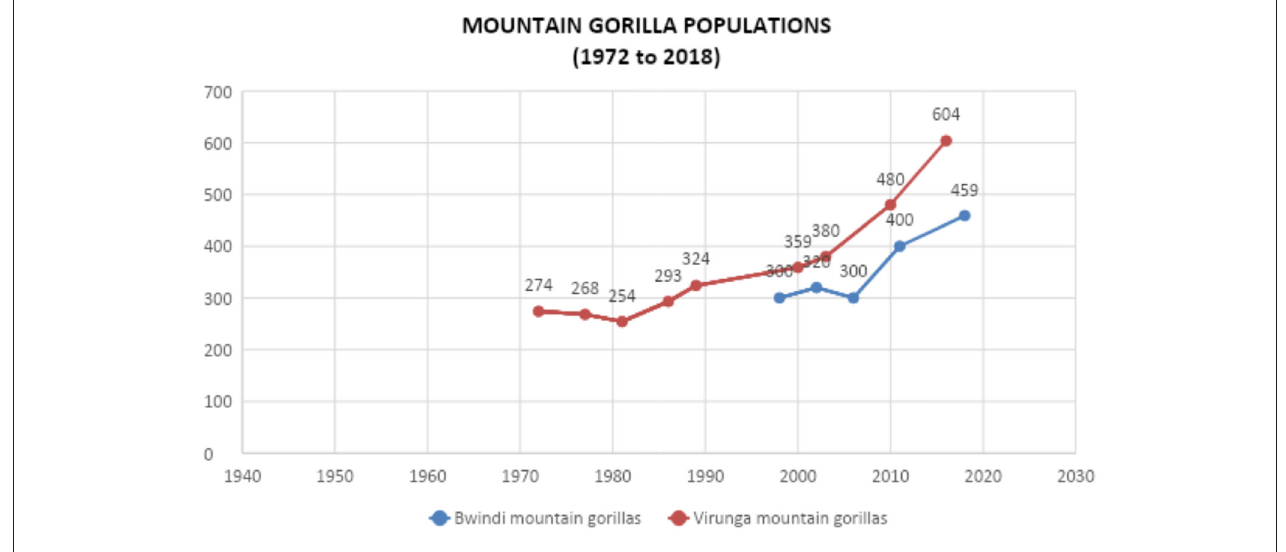
FIGURE 1 | Mountain gorilla population census results from 1970 to 2020 (Source compiled by Conservation Through Public